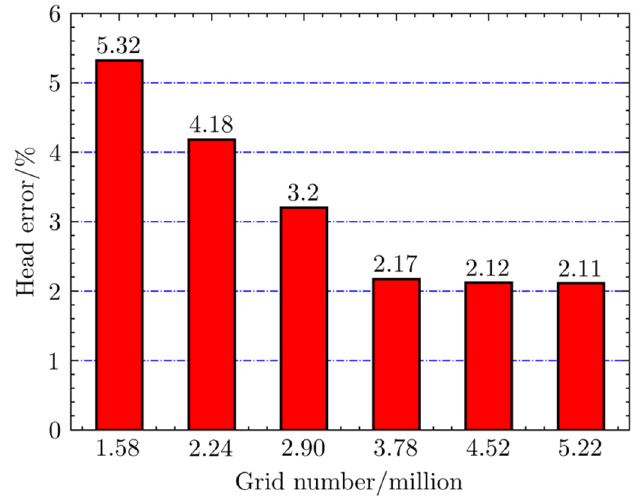
Figure 2. Grid independence check.